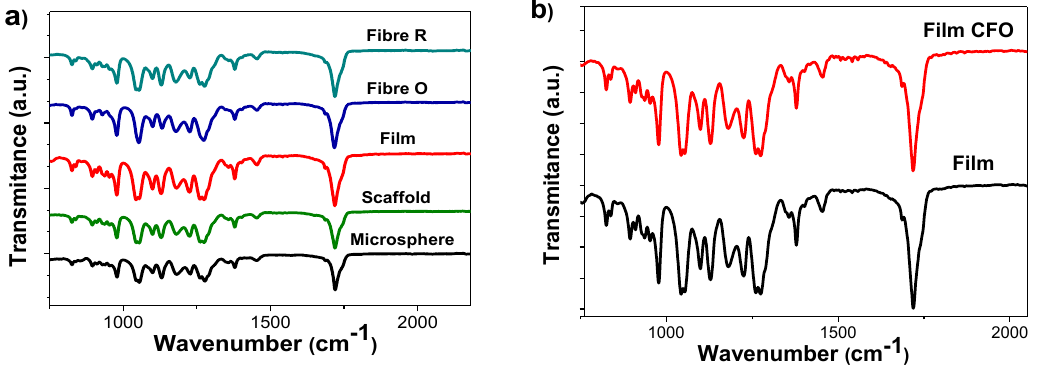
Figure 2. FTIR-ATR spectra of the ( a ) neat PHBV processing into different morphologies and ( b ) PHBV/CFO film composites.